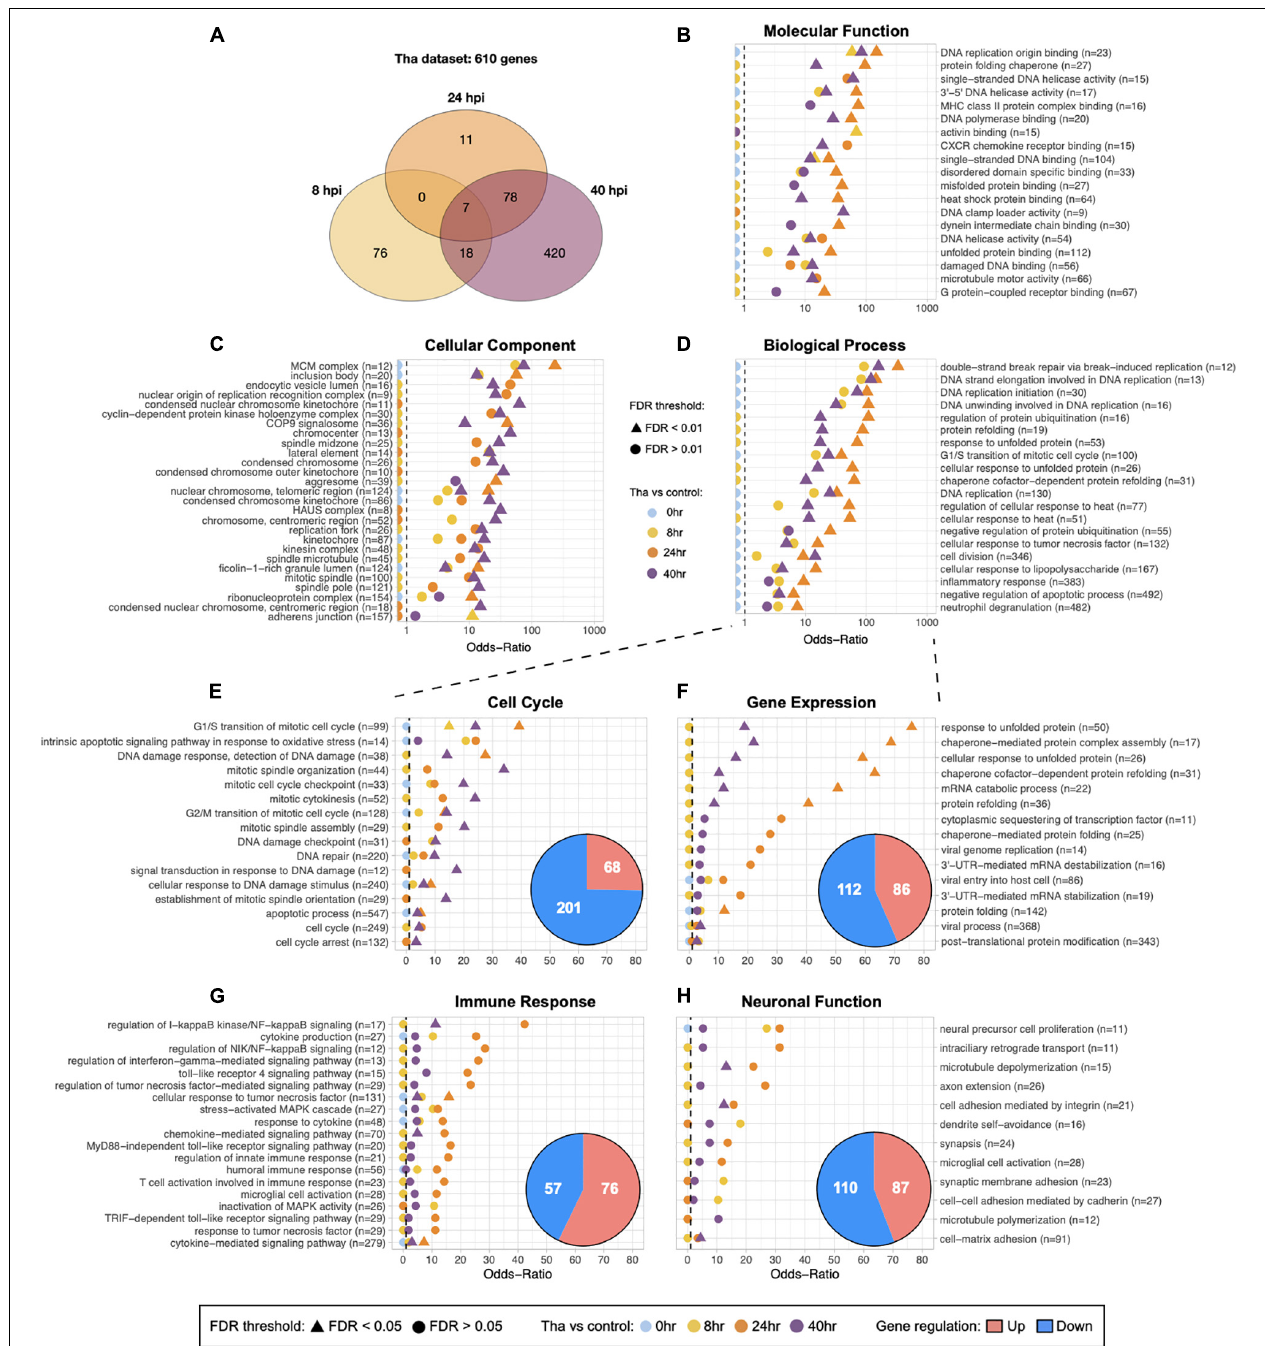
FIGURE 1 | Global and specified GO analysis of DEGs upon Tha infection. (A) Venn diagram for the number of genes that were significantly regulated at one time-point or more. (B–D) Subsets of categorized GO terms identified with Tha-induced DEGs were presented in each panel. The GO terms for Molecular Function (B) and Cellular Component (C) were selected by False Discovery Rate (FDR) < 0.01, size of geneset from 20 to 200, or the number of DEGs > 5 for display. Twenty GO terms from Biological Process were selected among the genesets that scored high Odds-ratios on 24 and 40 h time-points, and displayed on (D) . Full list of the selected GO terms for each categories is provided in Supplementary Table 4 . Biological Process was further filtered into 4 groups, Cell Cycle-related GO terms (E) , Gene Expression (F) , Immune Response (G) , Neuronal Function (H) and the number of up or down-regulated genes indicated in pie charts. The GO terms that have Odds-ratios higher than 10, or FDR smaller than 0.05 on at least one time-point are displayed in panels, and the full list the specified GO terms is provided in Supplementary Table 2 . The numbers in parentheses indicate the size of geneset for each GO term.